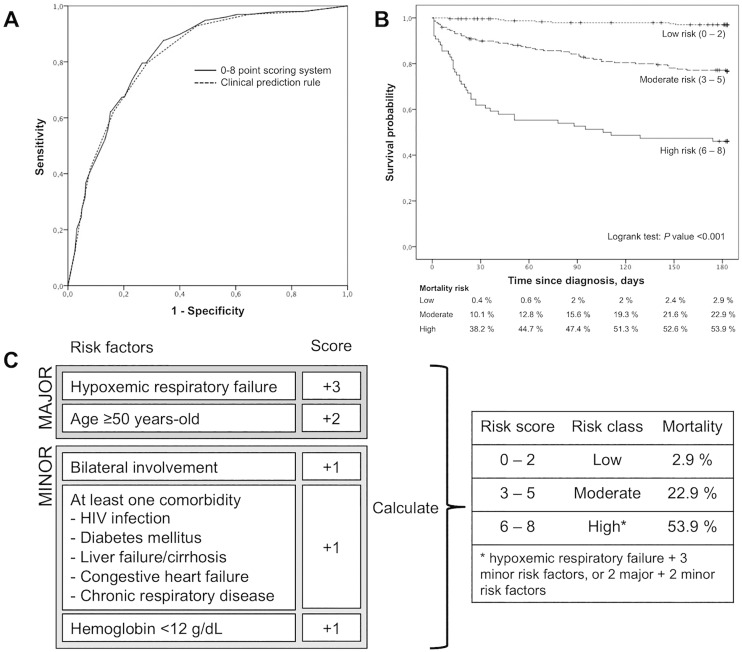
A—ROC curve for the logistic regression model (clinical prediction rule equation, S1 Fig) and clinical scoring system (0 to 8 points) | B—Kaplan-Meier estimates of survival in low-risk (clinical score 0–2), moderate-risk (clinical score 3–5) and high-risk (clinical score 6–8) tuberculosis patients. The mortality in each group at different time-points is shown below | C—TB risk assessment tool (TReAT), using baseline clinical features for stratifying patients with pulmonary tuberculosis into severity groups according to the probability of death at 6 months.